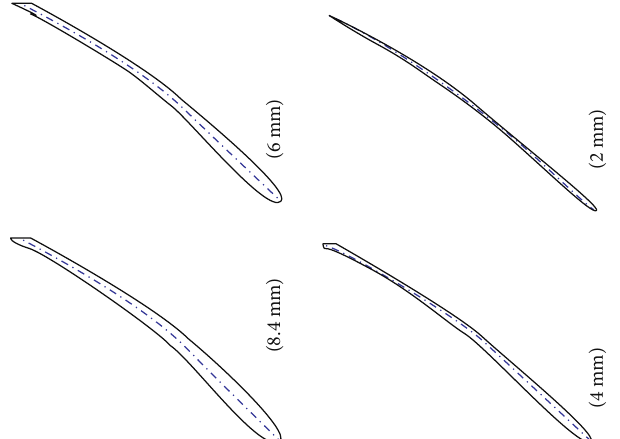
Figure 7: The disparities in blade thickness.